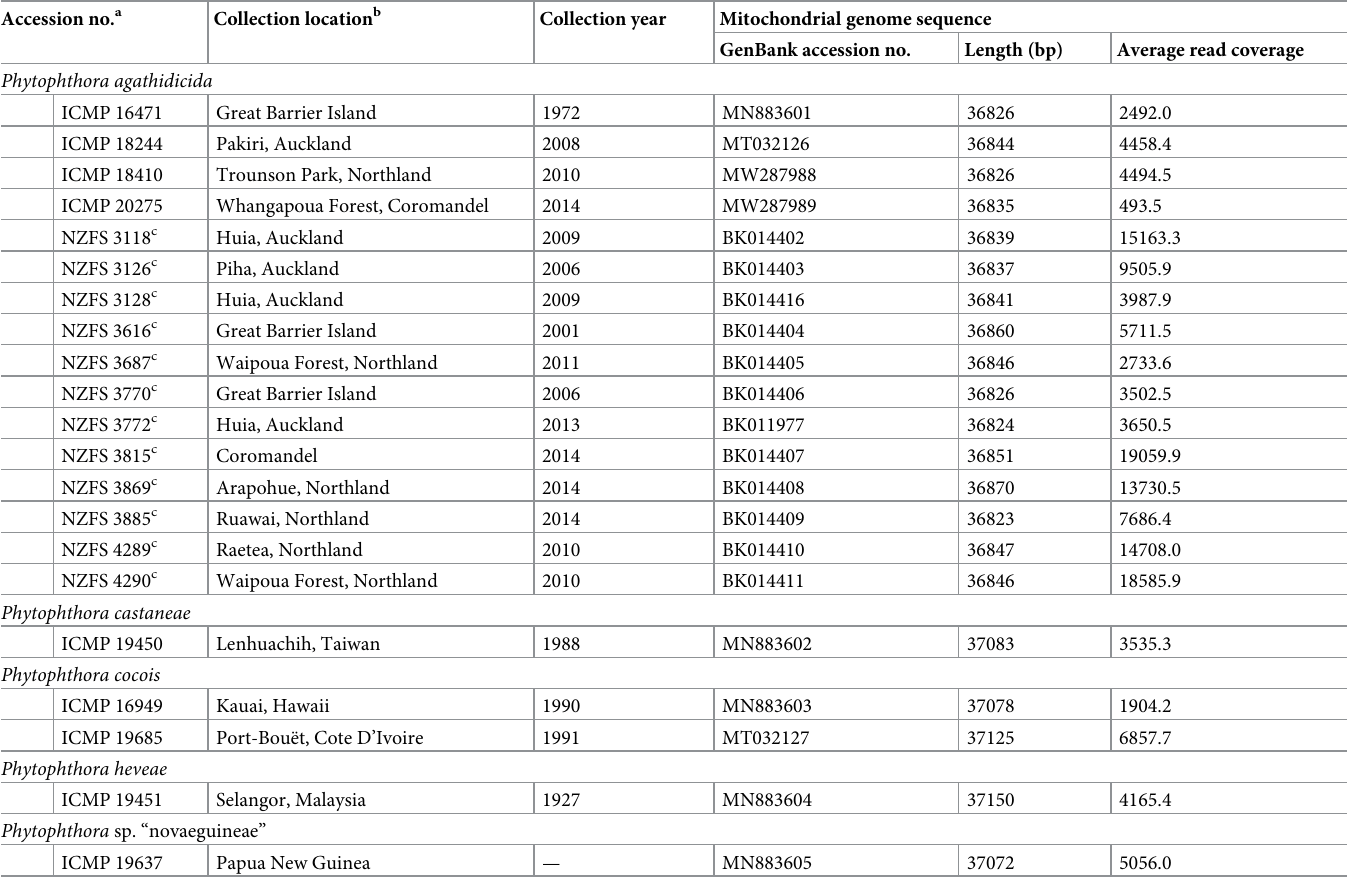
Table 1. Details of the sampled Phytophthora clade 5 accessions and corresponding mitochondrial genome sequences. Accession no.